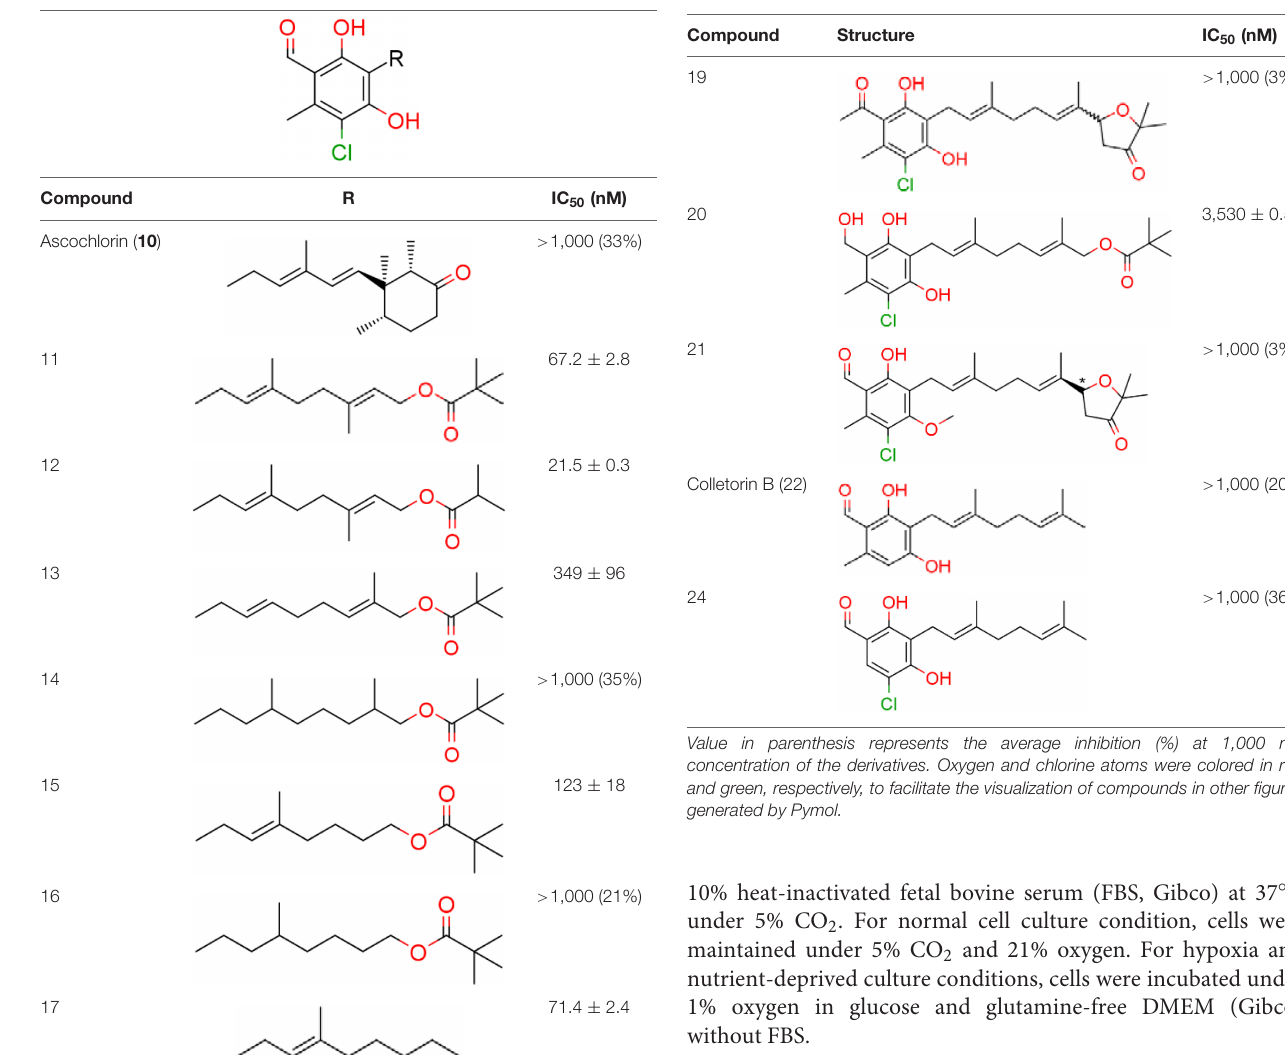
TABLE 3 | Inhibition of human DHODH by 1 derivatives with different substitutions on benzene